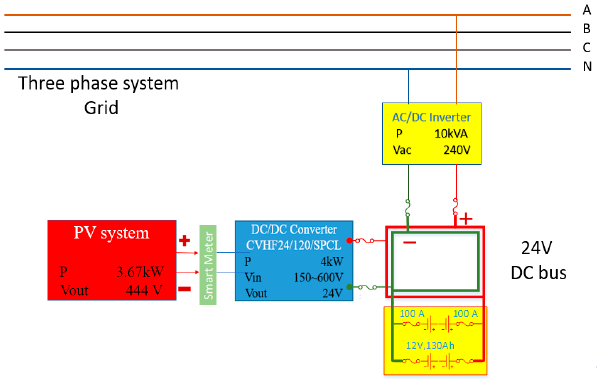
Figure 8. Single-phase EMS configuration.